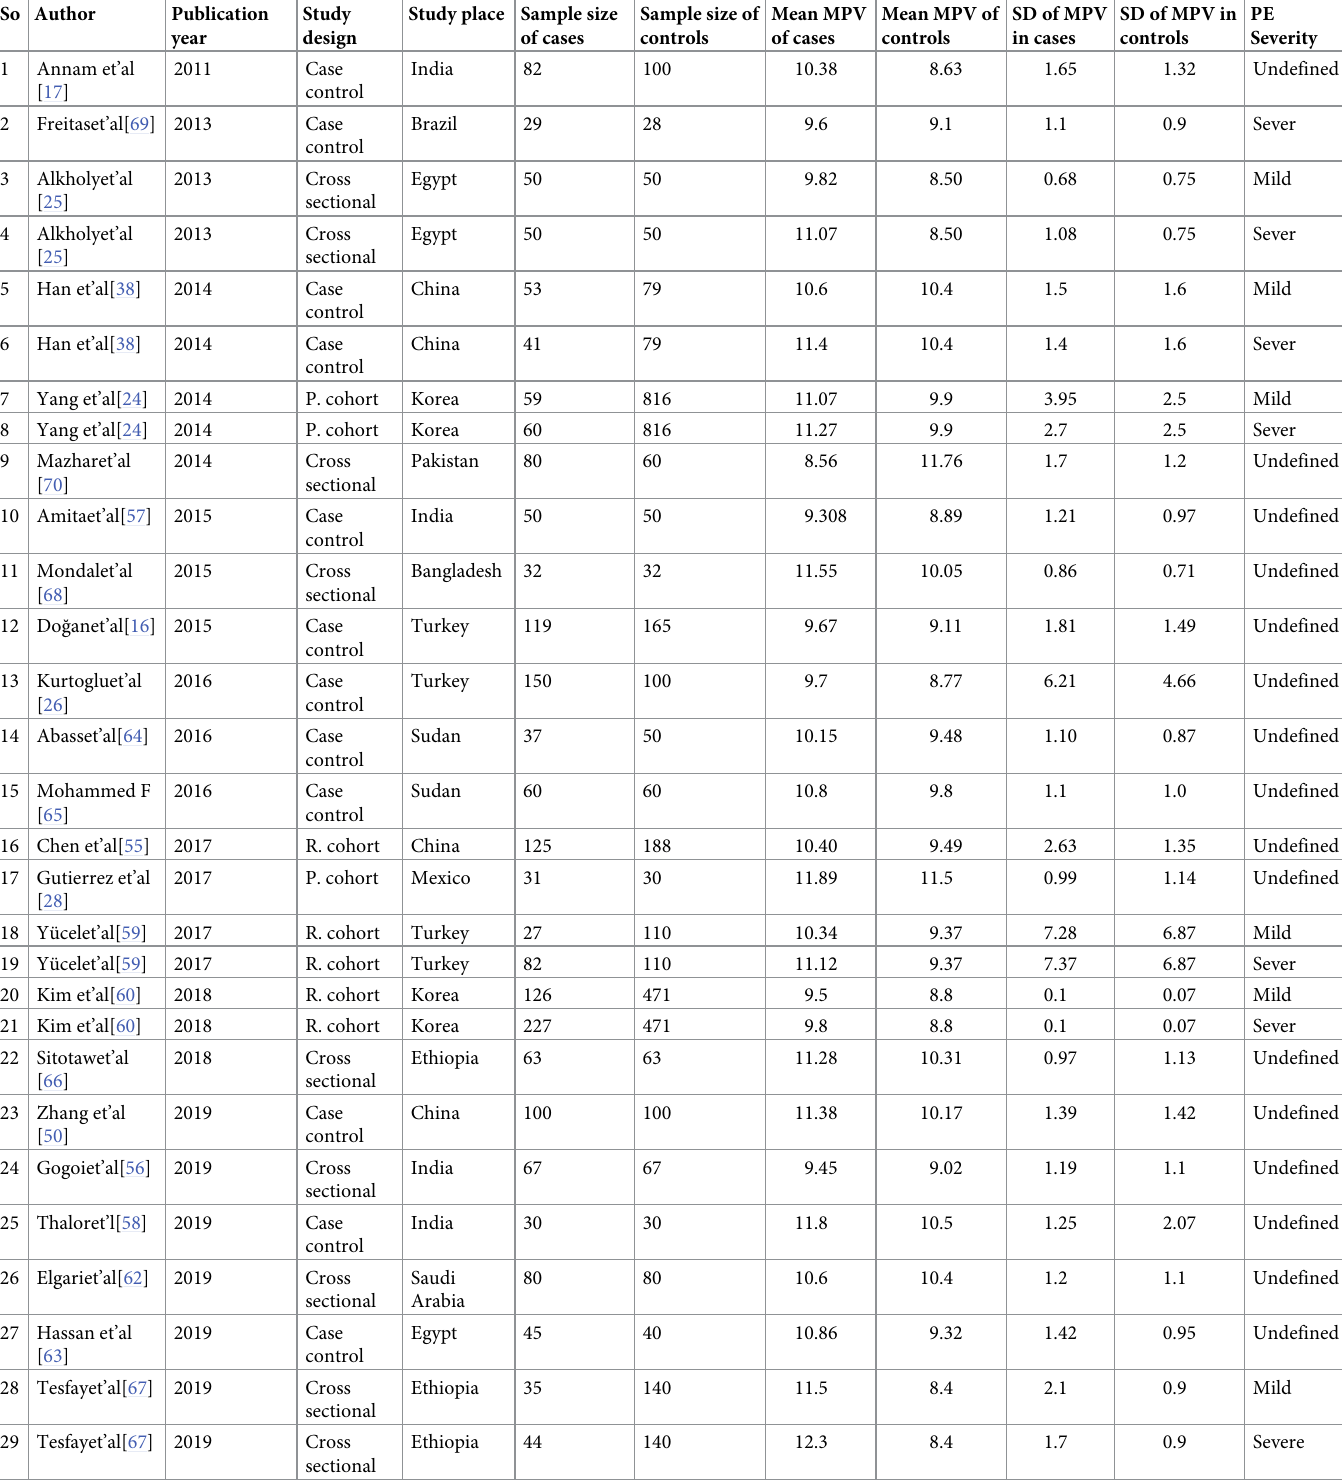
Table 2. Summary characteristics of included studies in the pooled WMD estimate of MPV between PE and NT groups. So